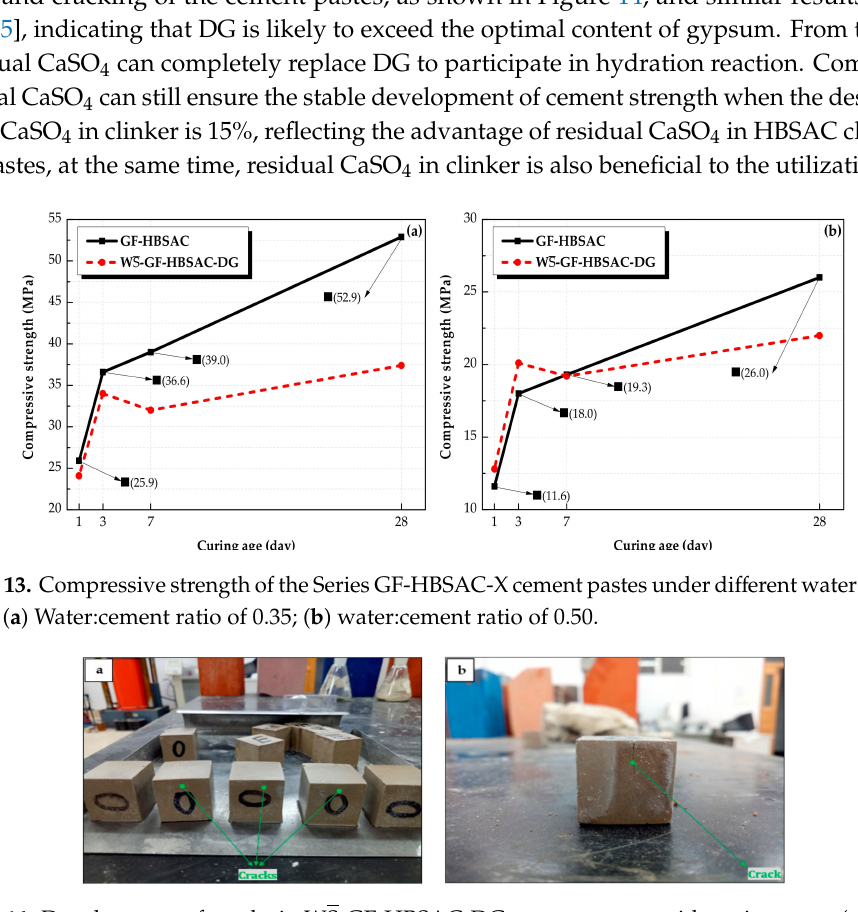
Figure 14. Development of cracks in WS-GF-HBSAC-DG cement pastes with curing ages: ( a ) Seven days; ( b ) 28